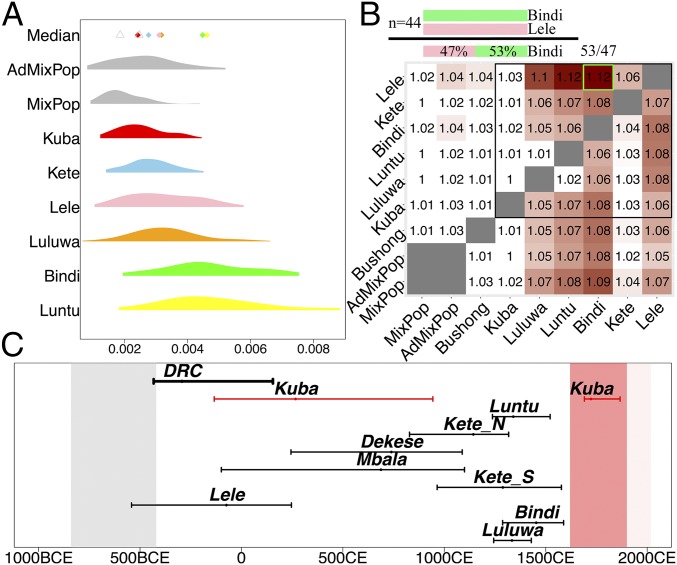
Kuba are less genetically isolated relative to other DRC groups. (A) Average lengths (cM) of tracts shared identical-by-descent (IBD) among pairs of individuals within each group and two simulated populations, MixPop and AdMixPop. Points along the top row provide the median value per group colored as in Fig. 1. The differences between the Kuba and Kete are significantly different following permutation-based resampling. (B) Average factor increase in the proportion by which members of a given ethnicity (column) share most recent ancestors with other individuals from their own group versus individuals from a different group (row), as illustrated in the Top schematic and green box. All groups are subsampled to contain n = 44 individuals to adjust for sample size effects. (C) Inferred dates (and 95% CIs) of admixture events in each DRC ethnicity when using all sampled groups as surrogate admixing sources, with vertical bands depicting the time periods of the Kuba Kingdom before Belgian colonization (red; ∼1620 to 1900) and the earliest local iron-working sites (gray; ∼840 BCE to 420 BCE). The inferred date when analyzing all DRC individuals jointly, using only non-DRC surrogate admixing sources, is shown in bold black.